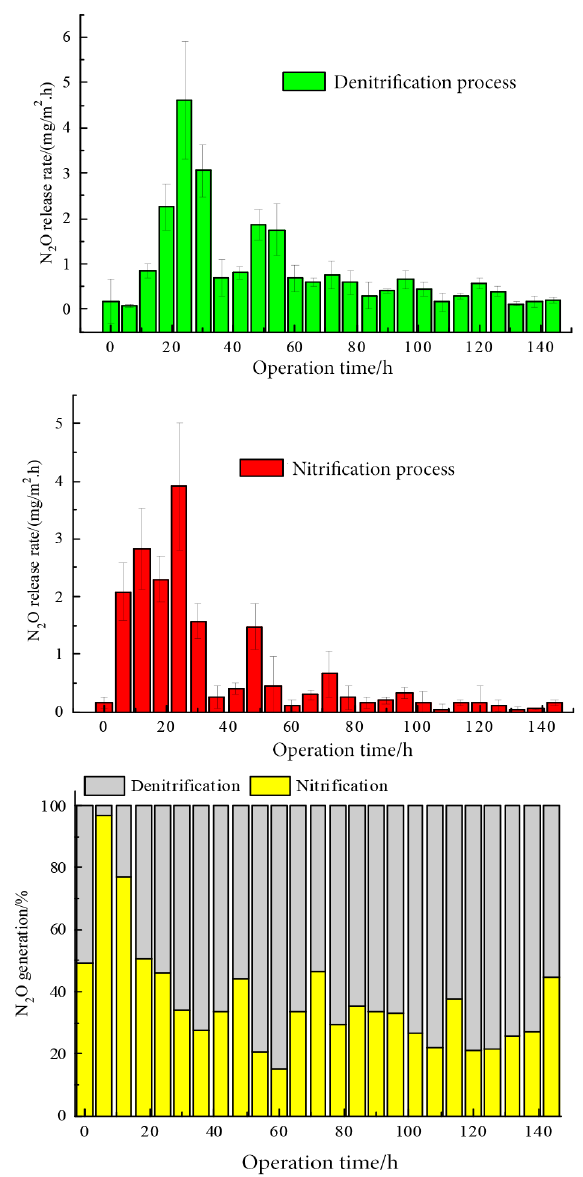
Figure 5. N 2 O produced by nitrification and